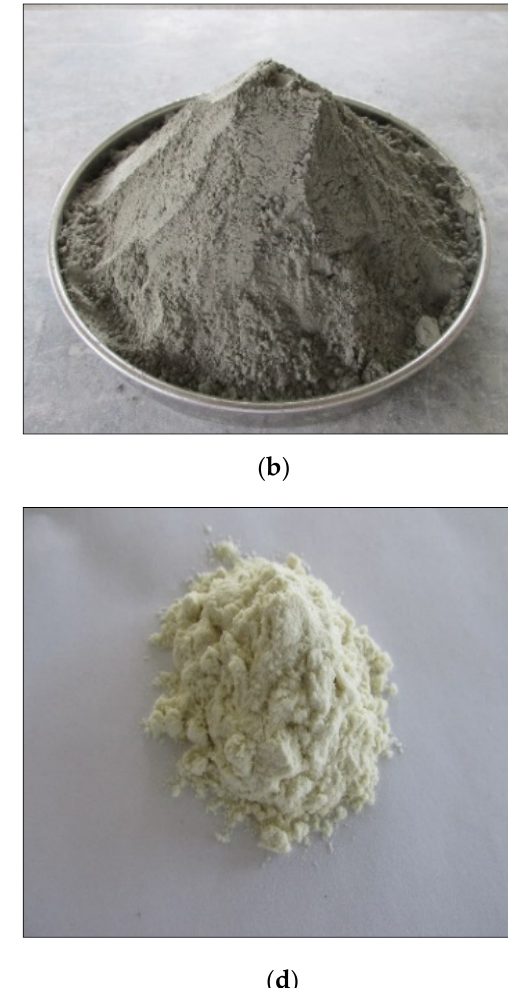
Table 3. Properties of basalt fiber (BF) used in the mortar specimens.